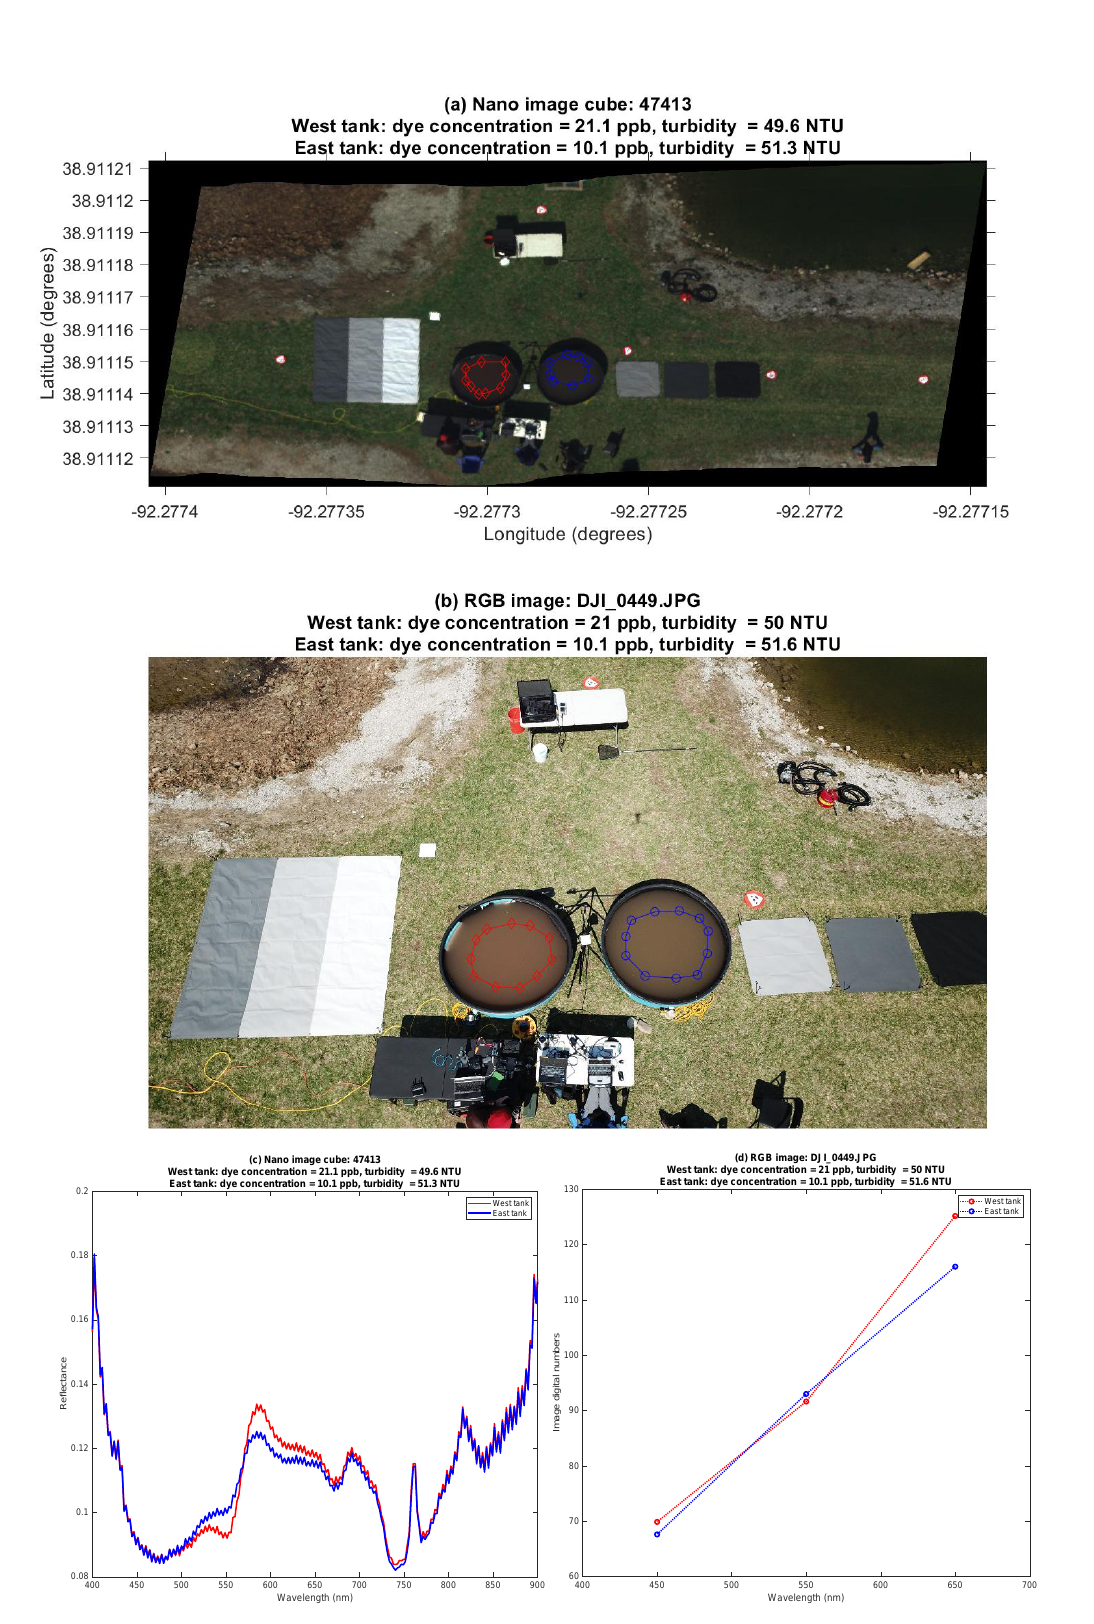
Figure 2. ( a ) Example Nano hyperspectral image. ( b ) Example RGB image. ( c ) Spatially averaged spectra extracted from the Nano image for the polygons digitized for each tank. ( d ) Spatially averaged pixel values extracted from the RGB image for the polygons digitized for each